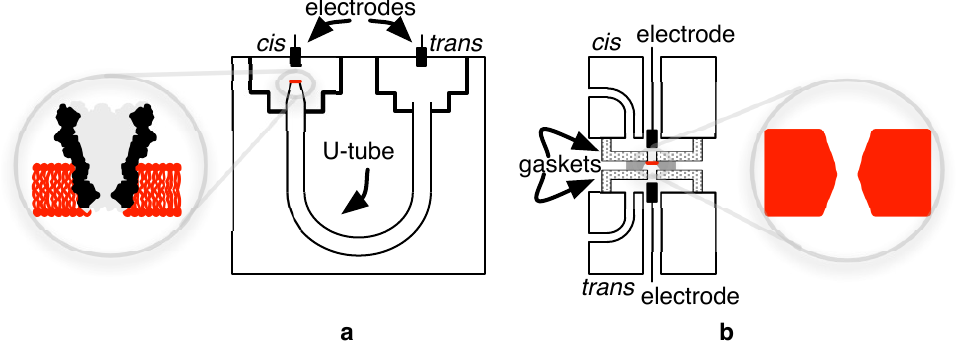
Figure 12. Examples of ( a ) a U-tube apparatus for biological nanopore testing and ( b ) its counterpart for solid-state nanopore